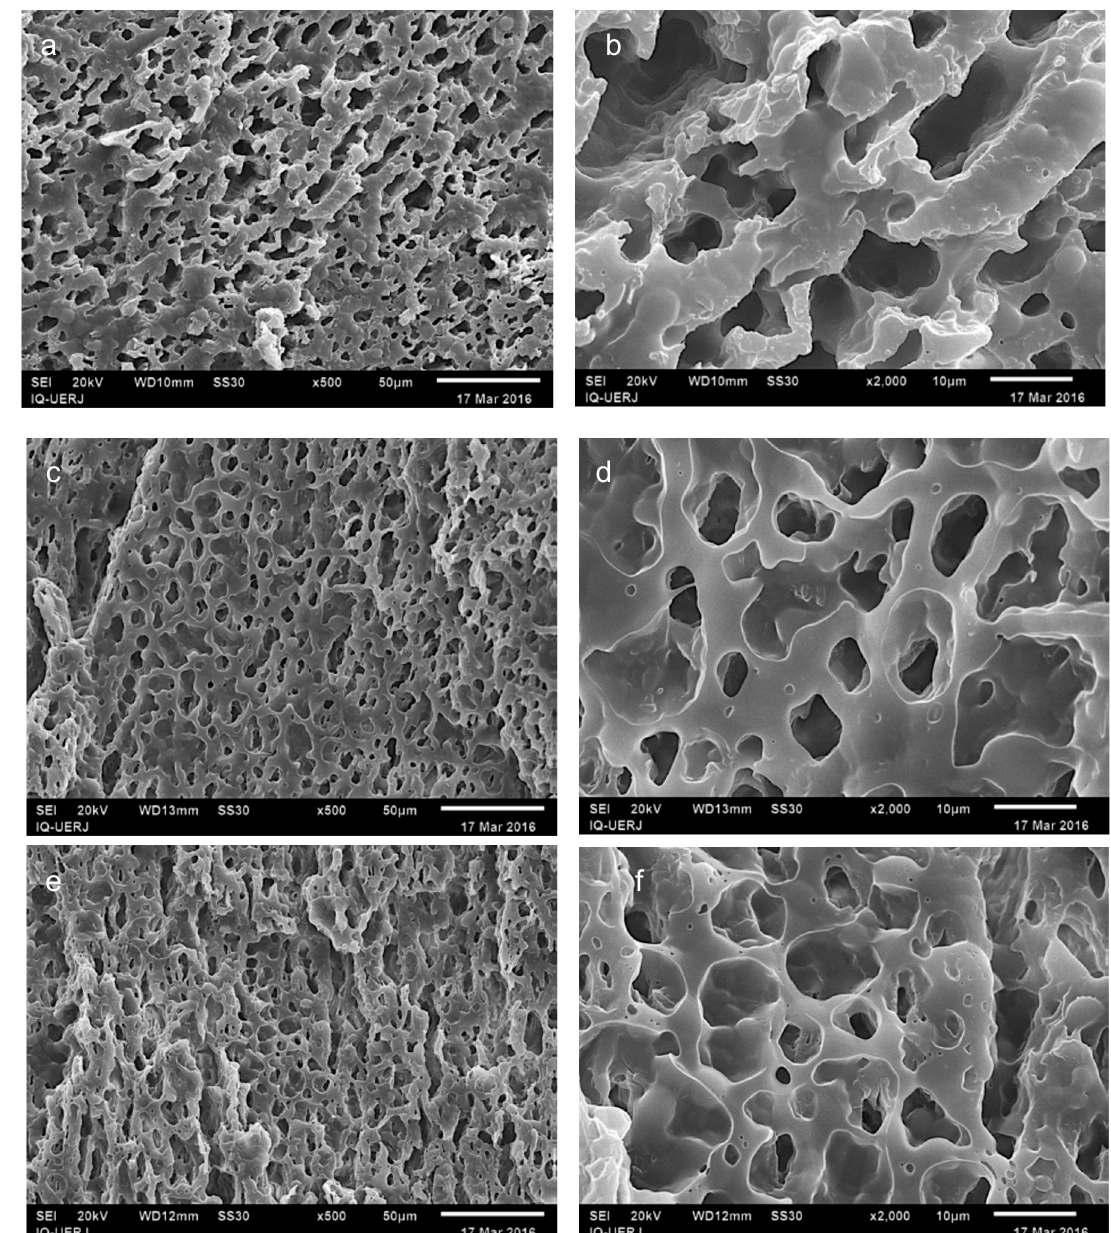
Figure 5. SEM micrographs of 3:2 PP/HIPS blends, after chloroform extraction: ( a , b ) without CNSL; ( c , d ) with 2.5 phr of CNSL; ( e , f ) with 5.0 phr of CNSL; images on left side, magnification of 500×; images on right side magnification of 2000×.